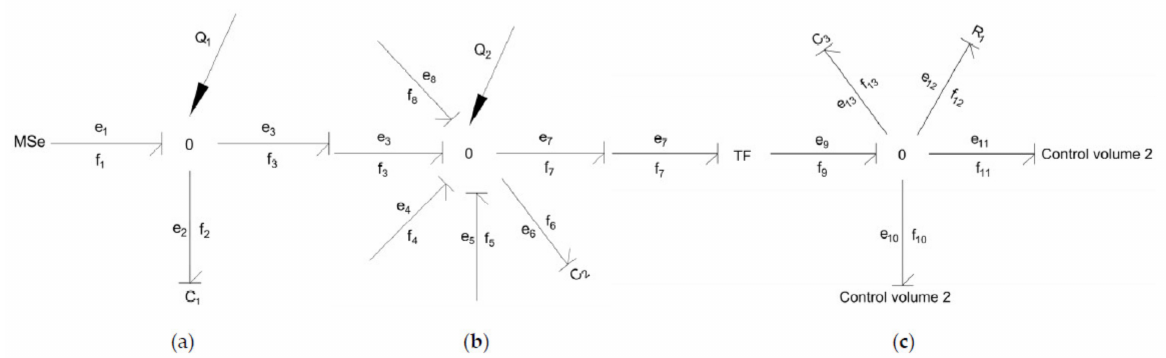
Figure 6. Bond graph model of the pressurizer: ( a ) control volume 1; ( b ) control volume 2; ( c ) control volume